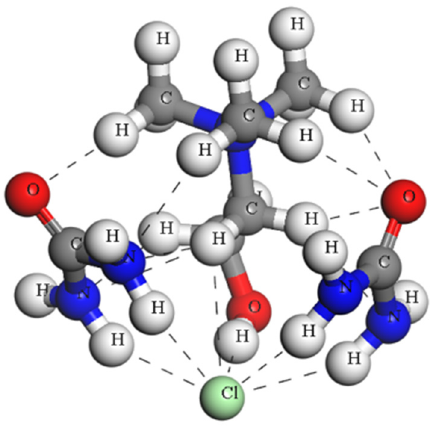
Figure 8. Molecular structure diagram of the ChCl-urea DES.